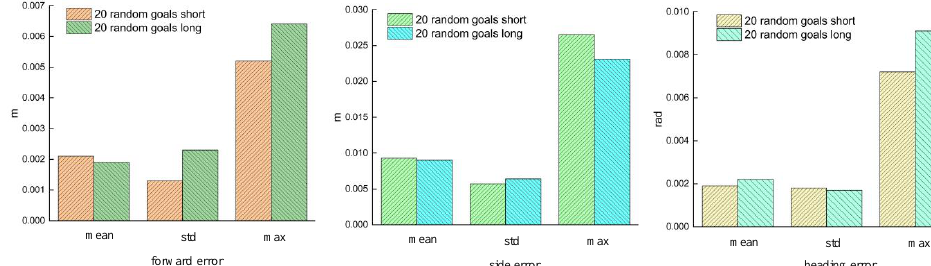
Figure 12. Error visualization description.